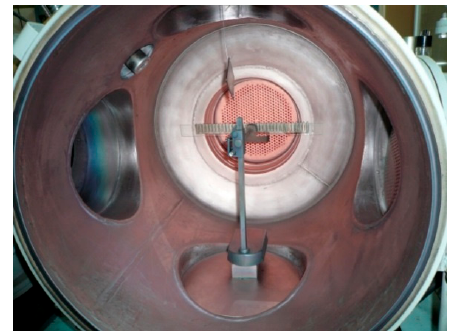
Figure 3. Chamber with the gas pre-ionization system on its wall (left) and the floating electrode.